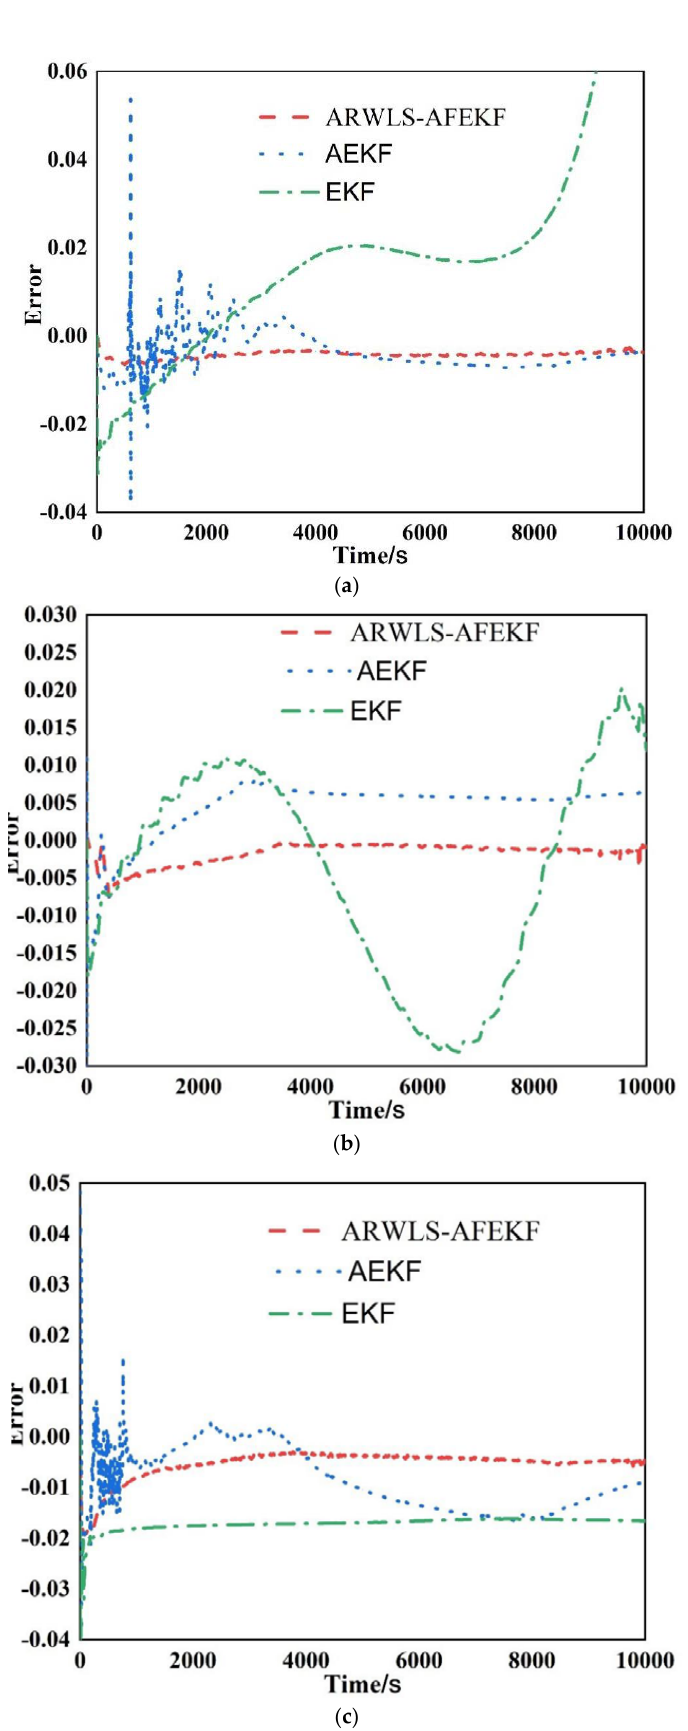
Figure 7. Estimation error under BJDST25 ( a ), DST25 ( b ), and FUDS25 ( c ) operating conditions.